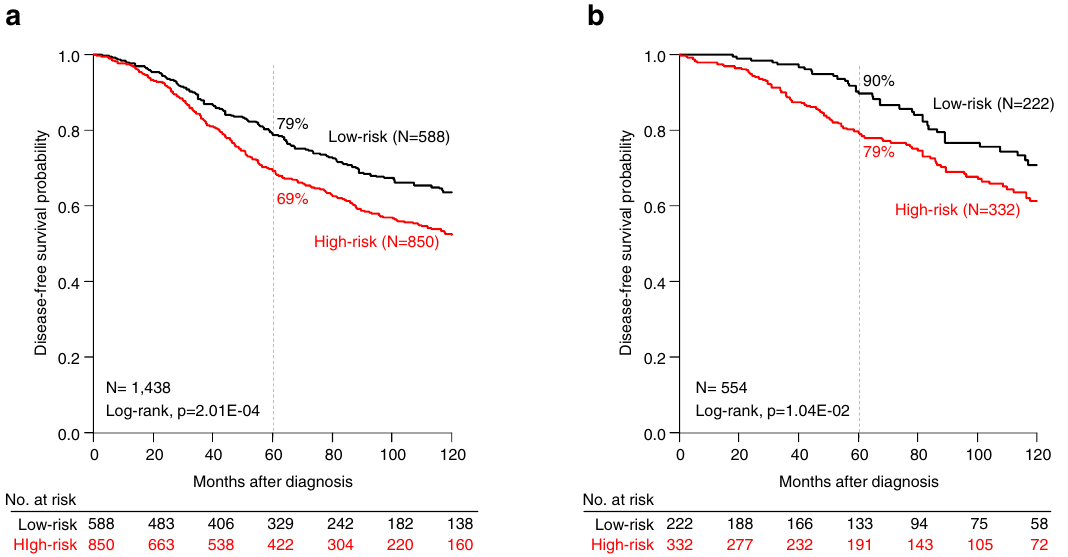
Fig. 2 Disease-free survival in Luminal B early breast cancer patients according to CINSARC signature. a Kaplan – Meier disease-free survival (DFS) in Luminal B breast cancer patients according to the two CINSARC classes (high-risk versus low-risk) in the overall population. b Similar to a , but only in patients receiving adjuvant endocrine therapy but no adjuvant chemotherapy.